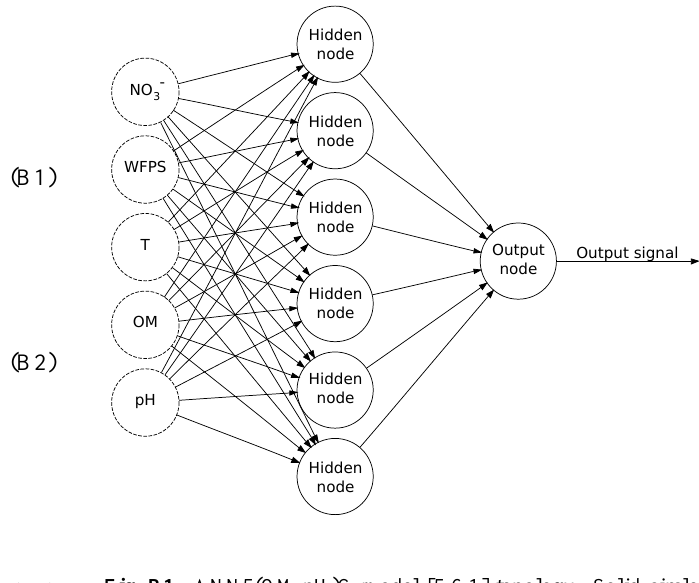
Fig. B1. ANN5(OM,pH)G model [5:6:1] topology. Solid circles represent neurons and dashed circles represent the